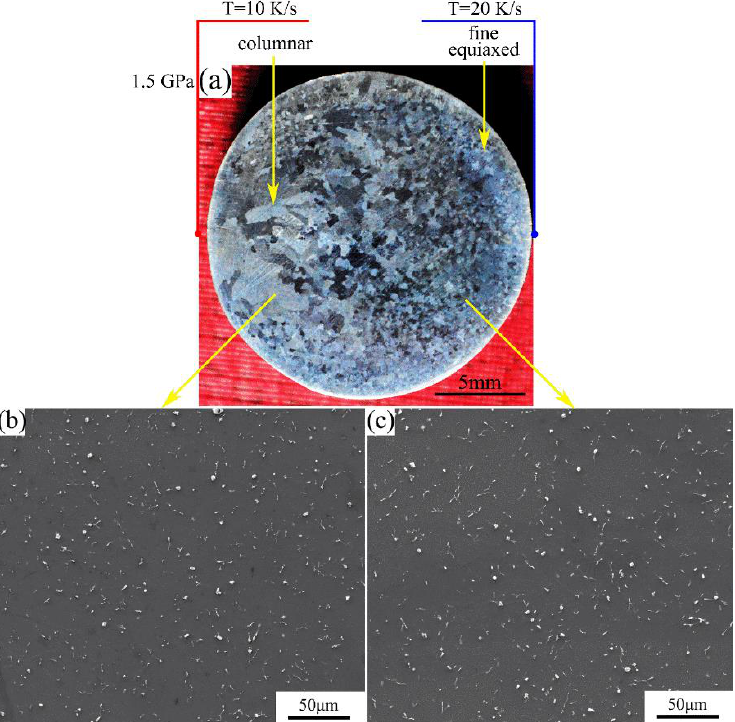
Figure 7. ( a ) Macrostructure and ( b , c ) microstructure of the Mg-1Sn-2.5Y alloy solidified under a pressure of 1.5 GPa: ( b ) columnar zone; ( c ) outer fine equiaxed zone.